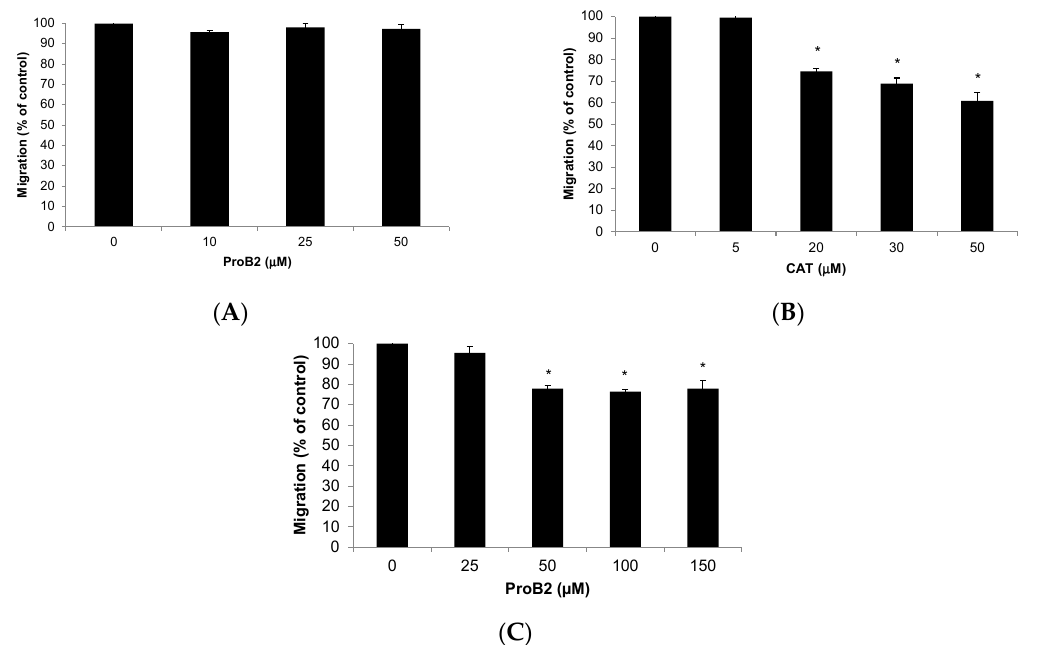
Figure 10. Effects of ProB2 and CAT on cancer cell migration. Cell migration of MCF-7 cells treated with: ( A ) ProB2 or ( B ) CAT. ( C ) Cell migration of DU145 cells treated with ProB2. Columns, mean; bars, SE (n = 3). * represents the significant difference between ProB2 or CAT treatment and control treatment ( p < 0.05; one-way ANOVA). Abbreviations: CAT, catechin; DOCE, docetaxel; ProB2, procyanidin B2.